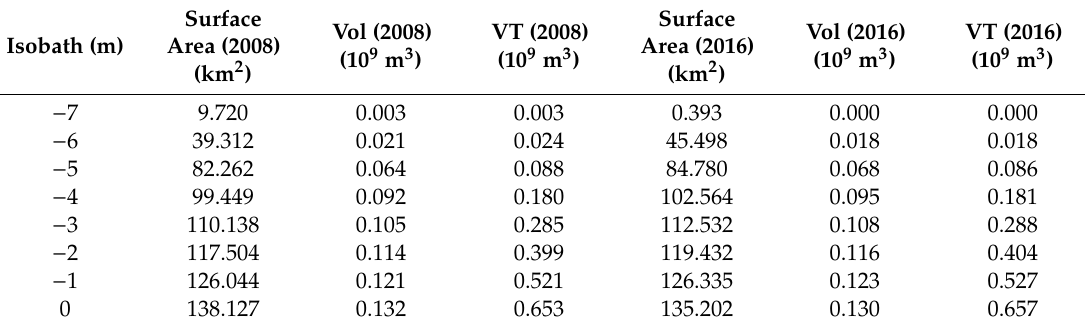
Figure 15. Bathymetric evolution of Mar Menor between 2008 and 2009 and between 2016 and 2017. Table 4. Estimates of the surface areas and volumes per isobath, as well as the total cumulative volume of Mar Menor in 2008 and 2016.